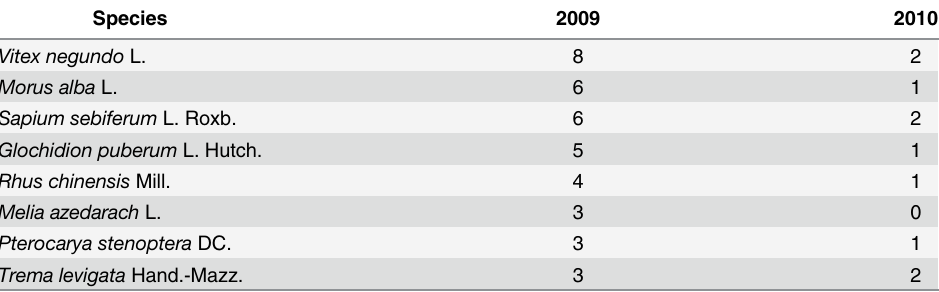
Table 5. Comparison of total established sites number in twelve sampling sites of eight woody plant species in both 2009 and 2010. Data from 2009 survey for Vitex negundo L., Morus alba L., and Sapium sebiferum L. Roxb. as previously reported in [13].